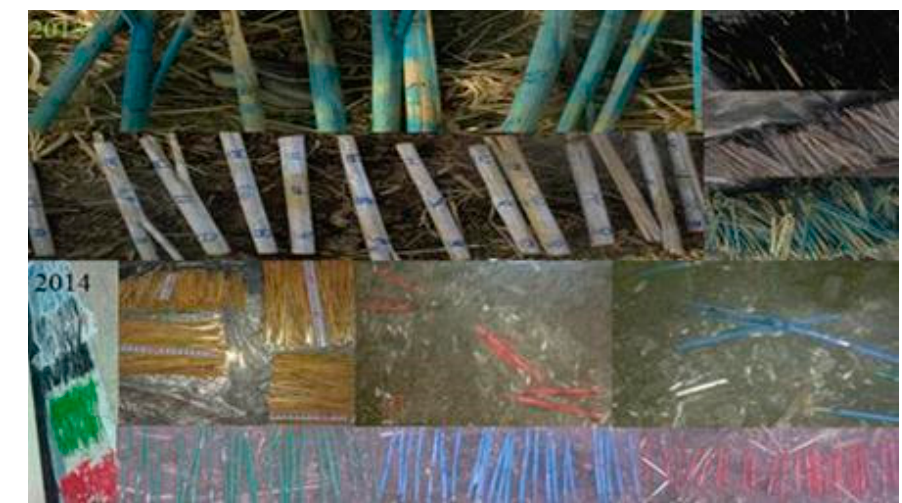
Figure 5. An overview of the straw tracer used in the study for displacement analysis (100, 150, and 250 mm length of tracer used in 2013 with label, color and number), (75, 125, 175, and 250 mm length of straw tracer used in 2014).